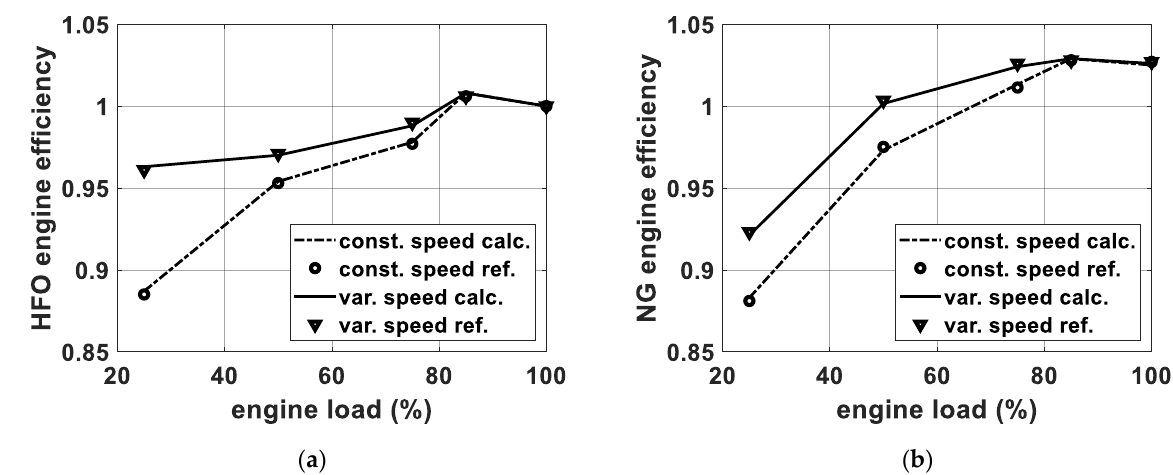
Figure 4. Comparison between calculated and reference efficiencies (normalised with respect to the HFO-powered TC engine) in diesel fuel mode ( a ) or gas mode ( b ).